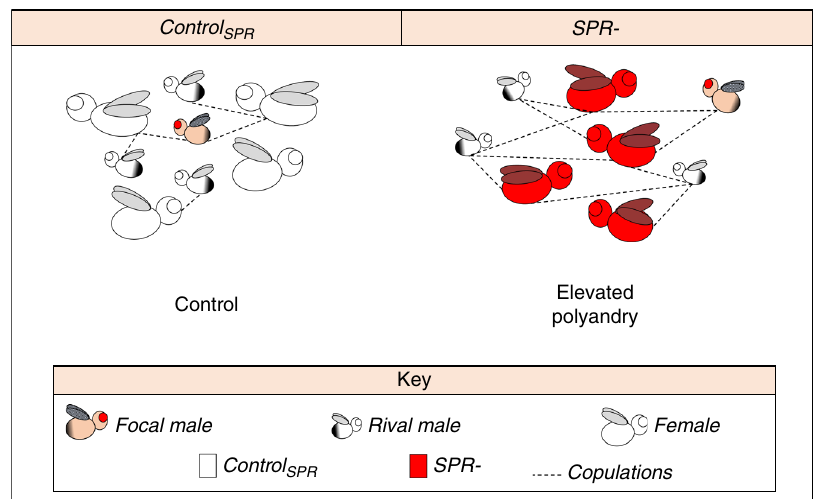
Fig. 1 Schematic representation of the SPR − manipulation used to increase polyandry levels in freely mating populations (representative copulation patterns indicated by dashed lines). White cartoons refer to groups consisting of wild-type females (control SPR ); red cartoons refer groups consisting of sex-peptide receptor -lacking females ( SPR −